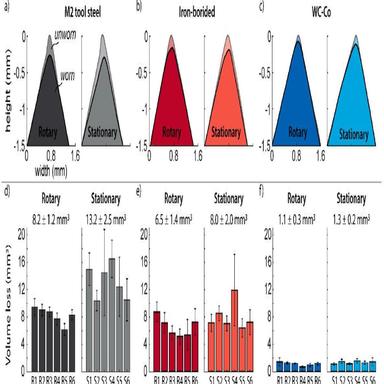
Wear of the blade tips measured with a 3D laser confocal microscope. Comparison of unworn and worn tips of the middle section of selected blades of a) M2 tool steel, b) Iron-borided knives, and c) WC-Co knives. Volumetric loss of the blades of knives d) M2 tool steel knives, e) Iron-borided knives, and f) WC-Co knives.